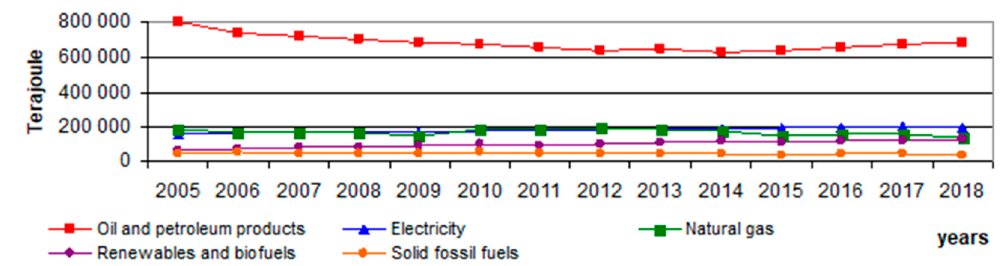
Figure 5 . Sources of energy used in agriculture in